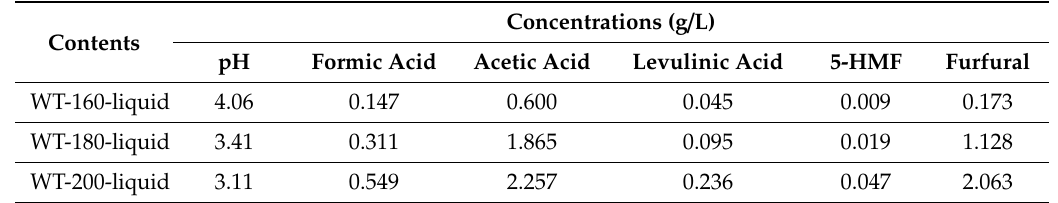
Table 4. Acid products analysis results of wet torrefaction